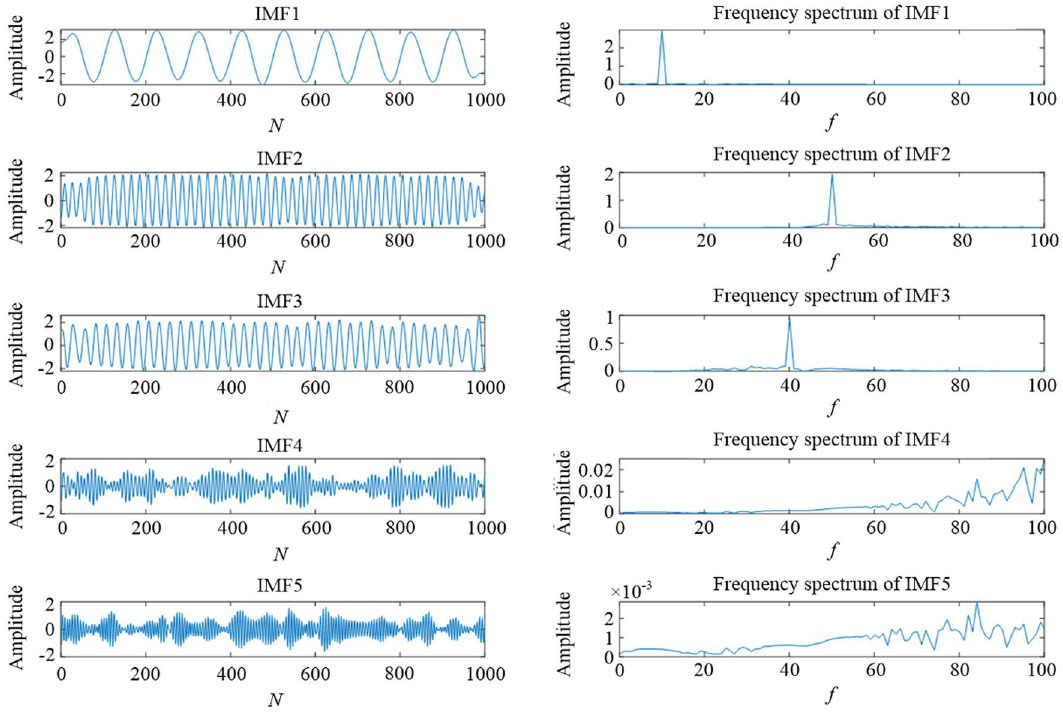
Figure 12. The component waveforms after VMD